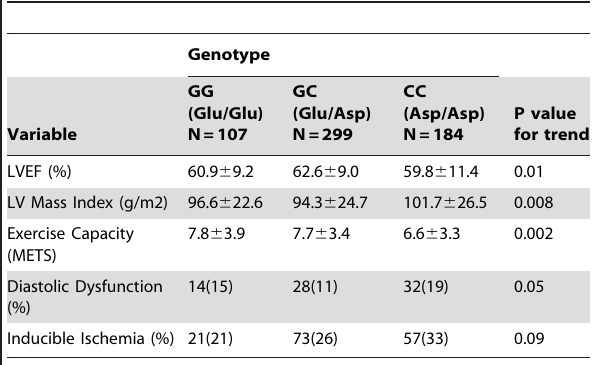
Table 2. Parameters of cardiovascular structure and function by genotype at rs2296545 (amino acid 37).